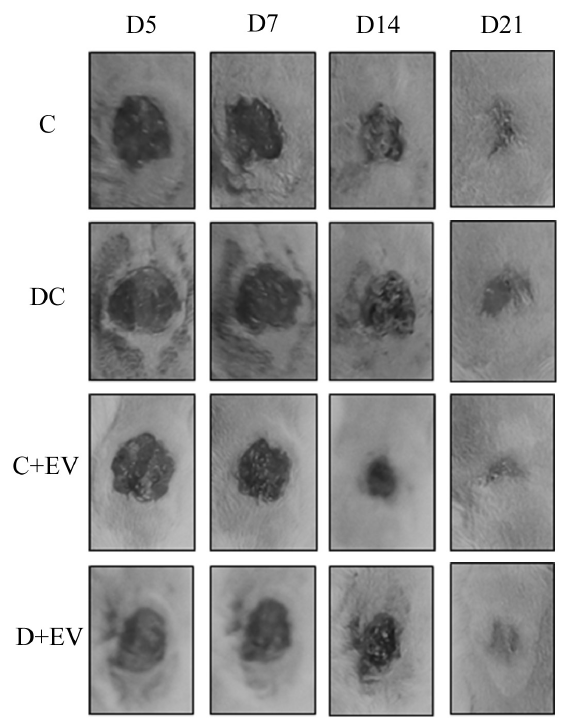
Figure 1. Comparative photos of one animal were randomly selected from each group on days 5, 7, 14, and 21. C: Control group, DC: Diabetic Control Group, C+EV: Control group that was administered Extracellular Vesicles, D+EV: Diabetic control group that was administered Extracellular Vesicles. D: